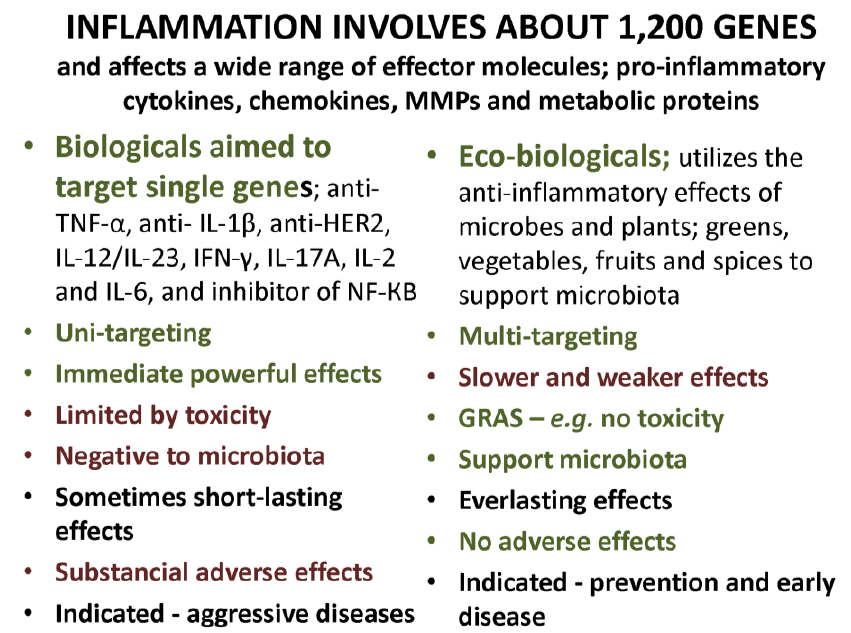
Figure 2. Molecular gene targeting to prevent or reduce severe systemic inflammation, development and cure of chronic diseases—effects of biological and eco-biological treatment